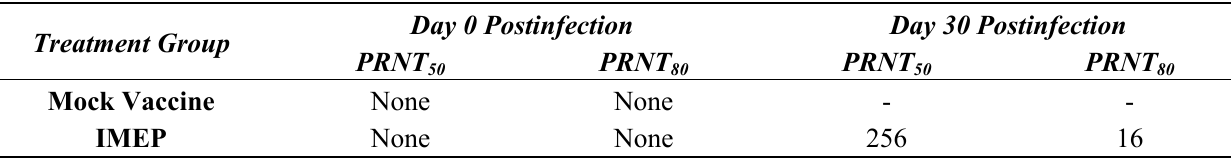
Table 1. Plaque-reduction neutralization test (PRNT) titers following vaccination (Day 0) and infection with LASV (Day 30) a